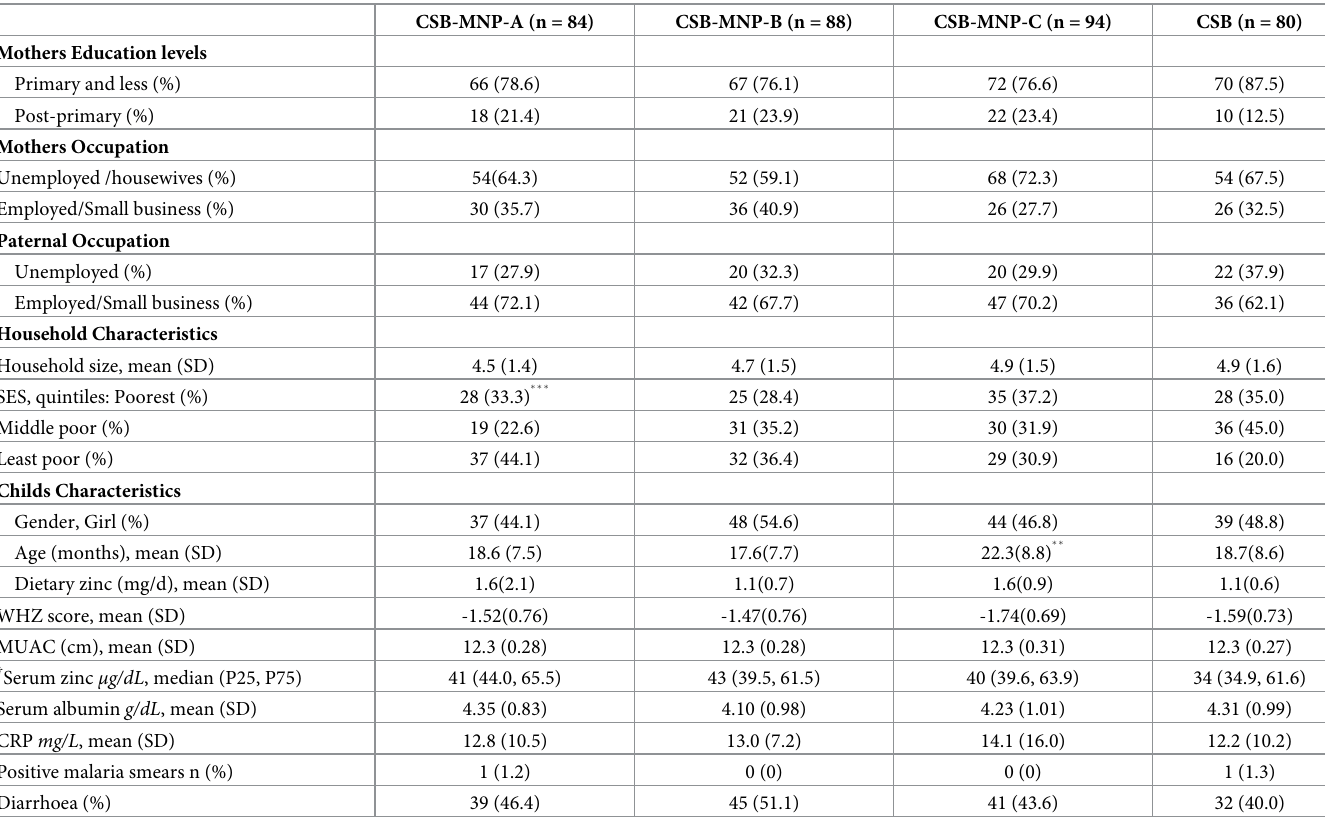
Table 2. Comparison of study groups at